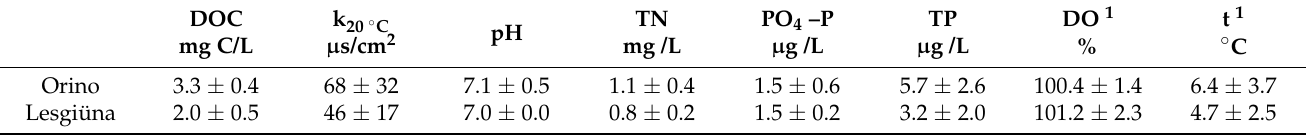
Table 1. Water physico-chemistry of the study reaches between February and May 2016 (mean ± standard deviation, N = 4). DOC, dissolved organic carbon; k 20 ◦ C , conductivity at 20 ◦ C; TN, total nitrogen; TP, total phosphorus; DO, dissolved oxygen; t,